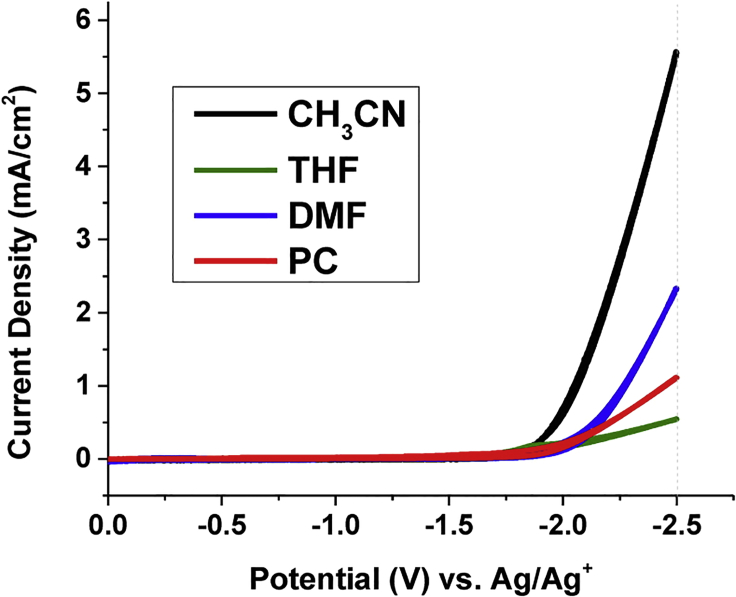
Cyclic Voltammograms Recorded at a Scan Rate of 100 mV·s−1 in 0.1 M Bu4NPF6 in Various Solvents versus Ag/Ag+ REReproduced with permission from (Berto et al., 2015).